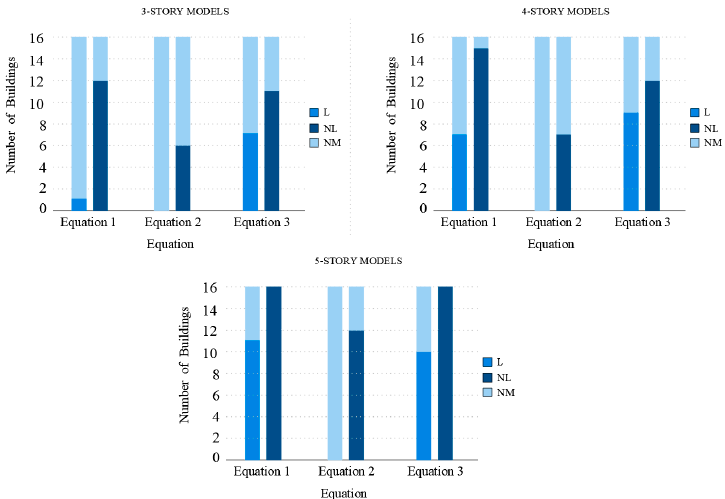
Figure 13. Distribution of buildings with sufficient performance according to the equation types/number of